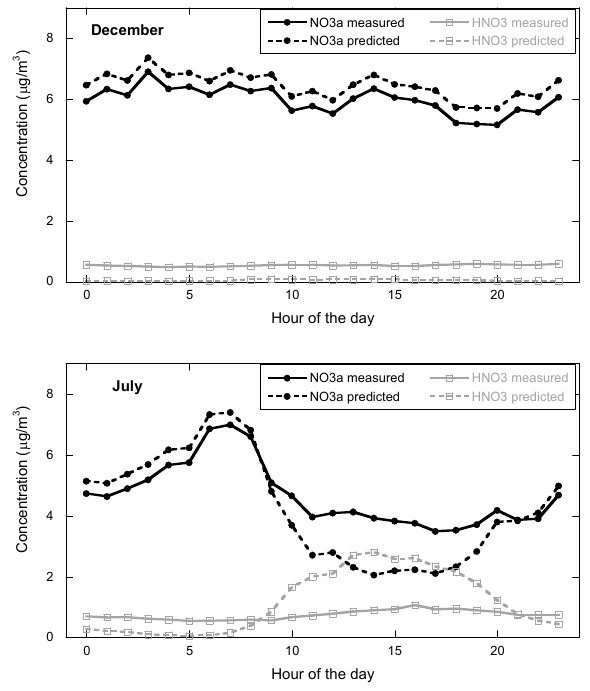
Fig. 7. Comparison between the measured partitioning of nitrate Figure 7. Comparison between the measured partitioning of nitrate between the aerosol and 4 between the aerosol and gas phase at Cabauw for December (up- gas phase at Cabauw for December (upper panel) and July (lower panel) with that predicted 5 per panel) and July (lower panel) with that predicted using ISOR- using ISORROPIA. For both months the average diurnal cycle is given. All hourly averages 6 ROPIA. For both months the average diurnal cycle is given. All consist of at least 23 data points. 7 hourly averages consist of at least 23 data